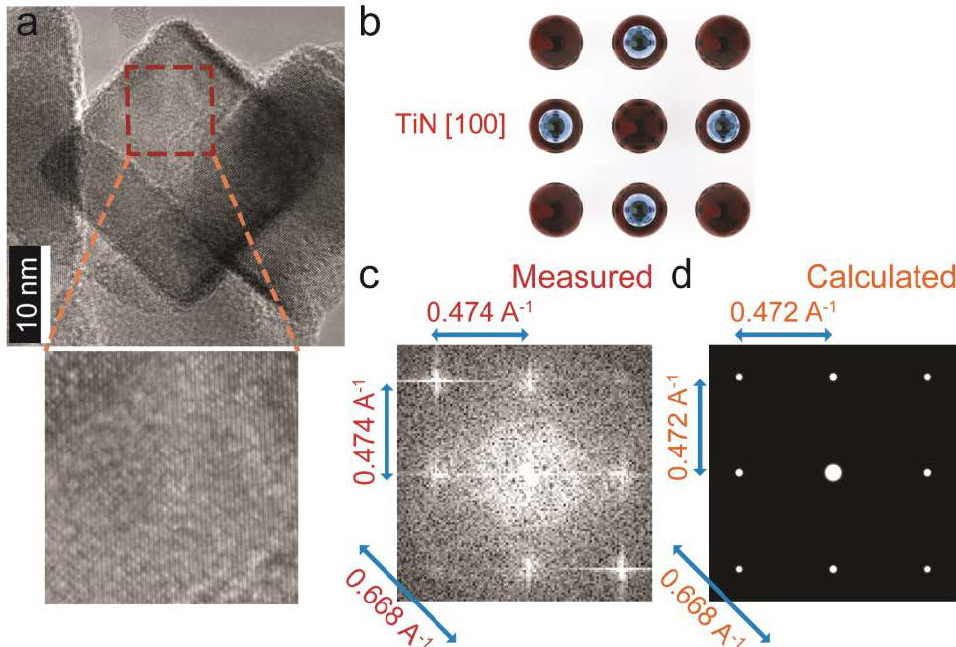
Figure 2: (a) HRTEM image of a single cubic TiN nanoparticle. The inset shows magnified image of the region designated with dashed rect- angle. (b) The unit cell of rock salt TiN crystal with [100] lattice vector pointing out of the page plane. (c) FFT diffractogram of the designated region taken from the HRTEM image. (d) Calculated FFT pattern from tabulated data [53]. Measured lattice constant, 4.22 Å, is in good agree- ment with tabulated bulk value, 4.24